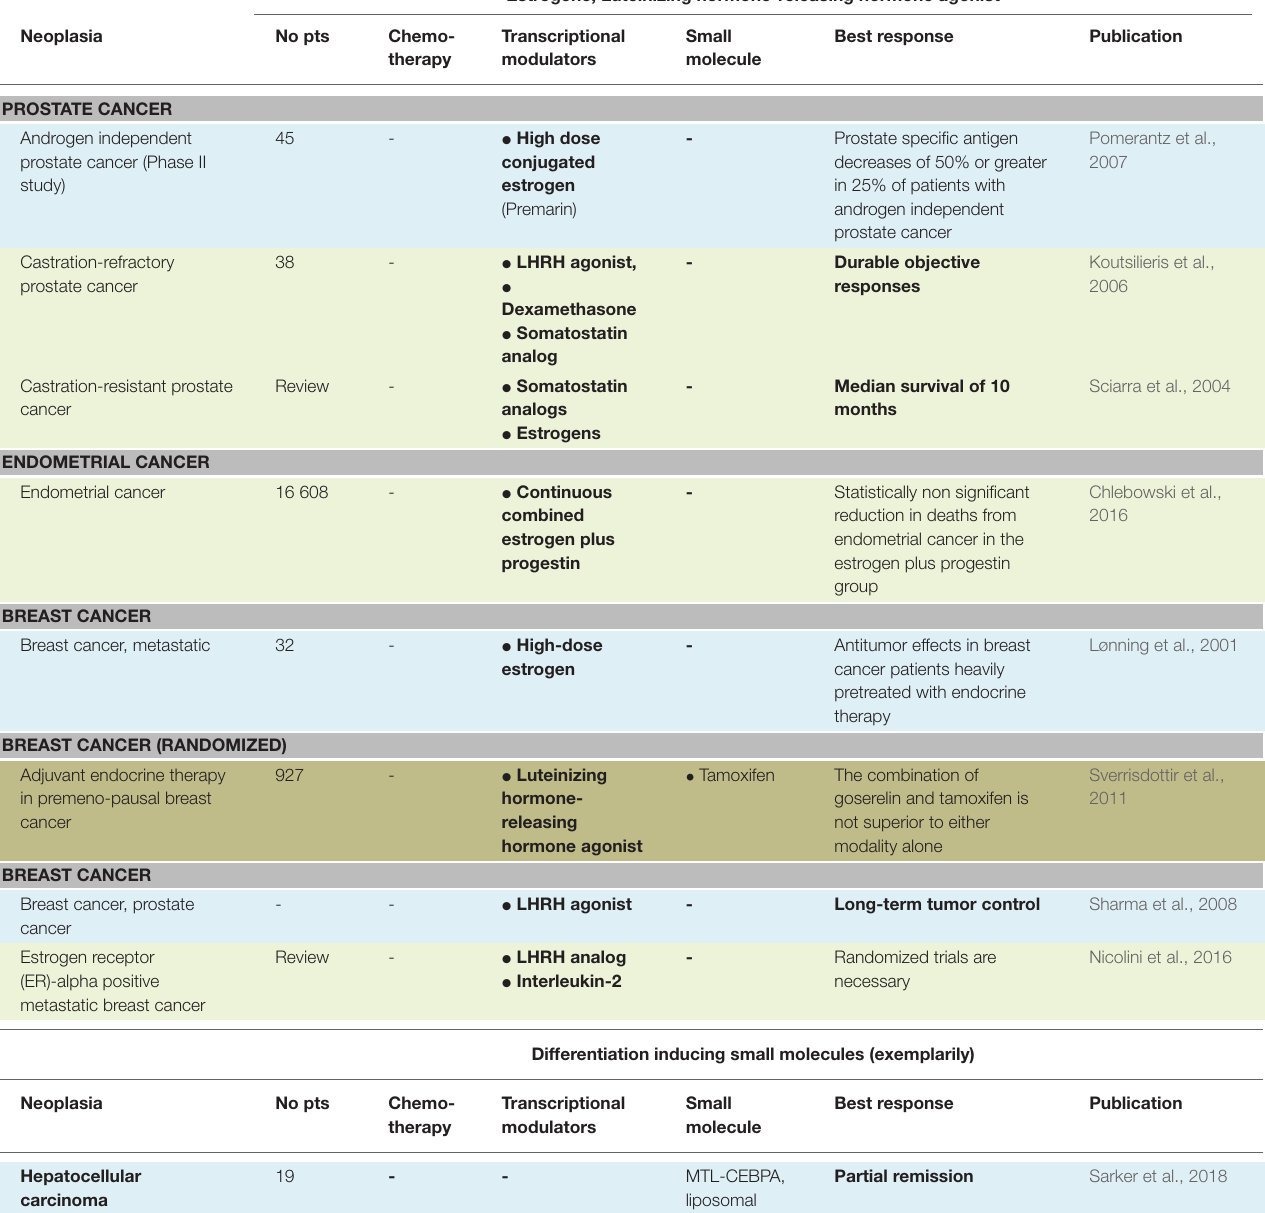
TABLE V | Communicative reprogramming of tumor